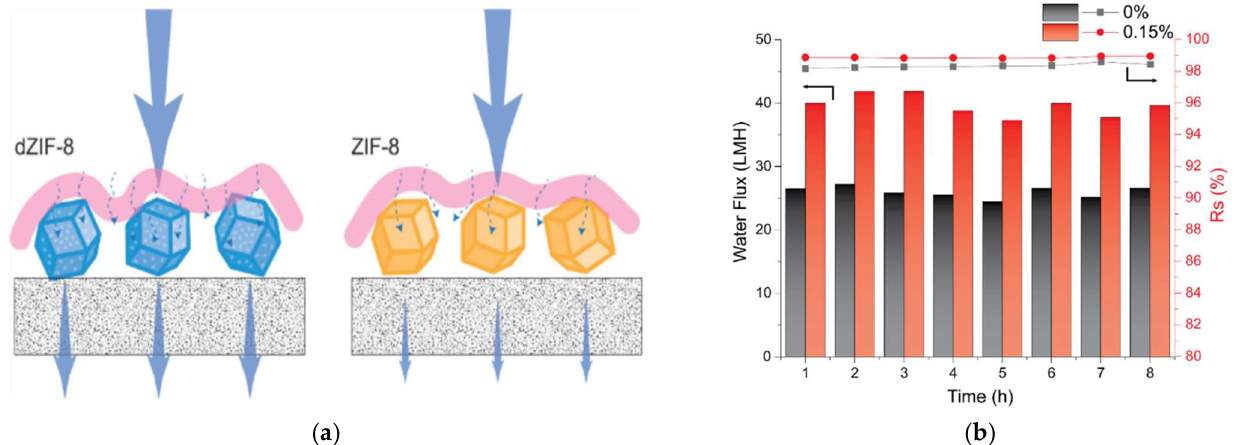
Figure 3. ( a ) Illustration of water permeance, ( b ) membrane desalination studies with dZIF-8 con- centrations in seawater (reproduced with permission from [35] copyright 2021, Elsevier).